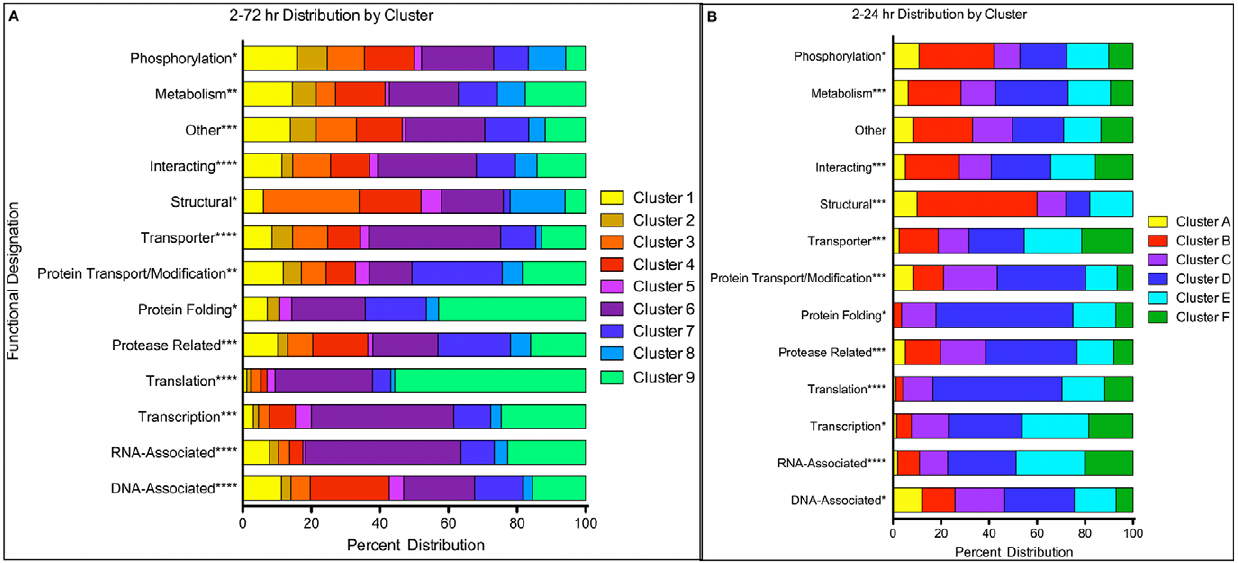
Figure 6. C.parvum Transcriptome 2–24 hr Relative Expression Cluster Analysis. The DIANA algorithm was used to cluster each gene’s relative expression using the absolute cosign distance metric. For the heatmap each gene is represented in one row and each column represents the percent expression at one time point. ( A )The relative expression (%) was determined for each gene’s median normalized value over the first 24 hr of the time course, which includes 4 time points (3297 genes). Six clusters (A–F) of genes are present with a dendrogram distance cutoff of 1, as depicted with the color bar to the right of the heatmap. ( B ) The average gene expression per cluster ( + / 2 SD) using the first 4 time points (24 hr) is plotted with the number of genes found in each cluster within the ().